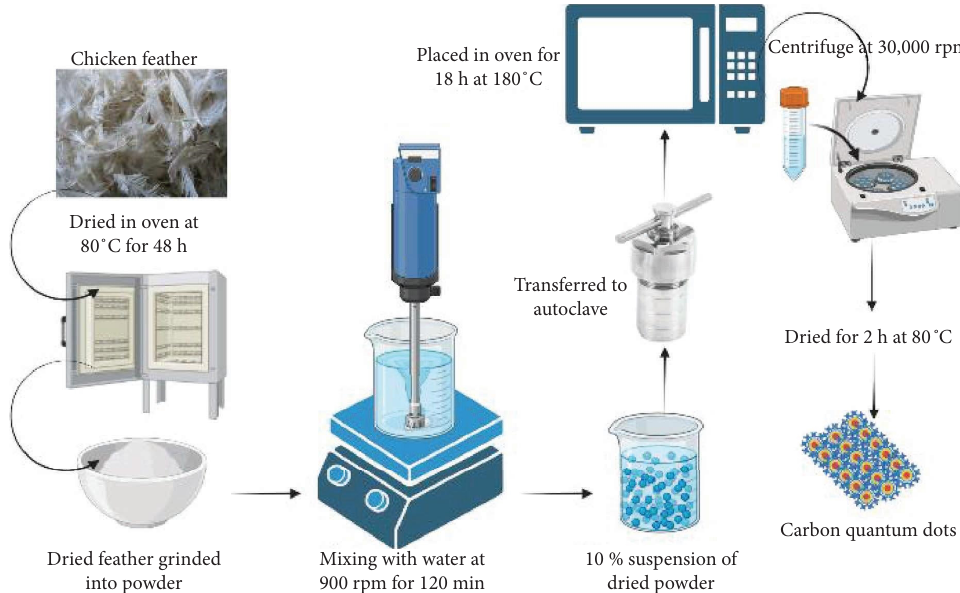
Figure 1: Schematic diagram for the preparation of